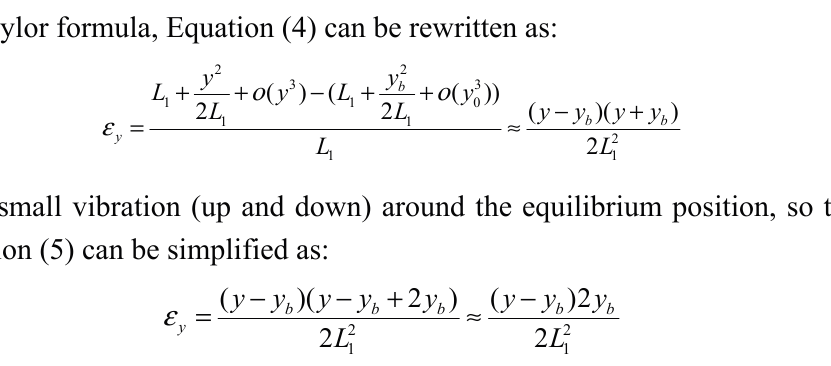
Fig ure 3. Vibration model of optical fiber in transverse